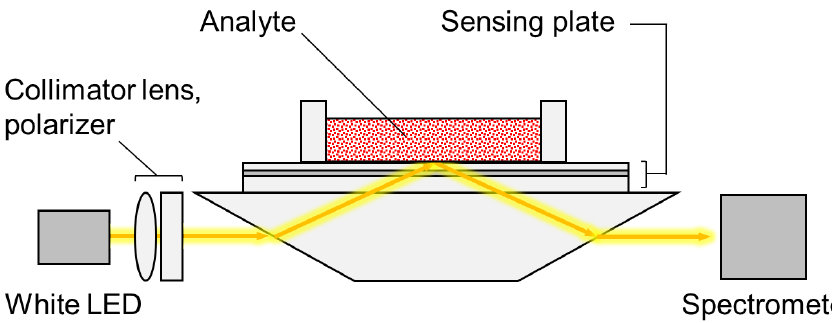
Figure 2. Schematic diagram of waveguide-mode sensor.